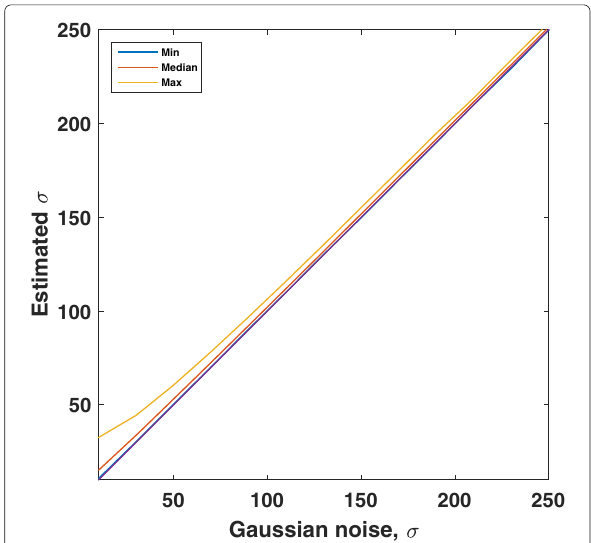
Fig. 10 Estimated standard deviation vs. true standard deviation for Gaussian